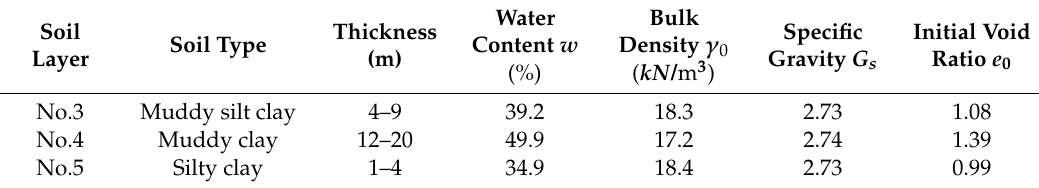
Table 2. Physical properties of the model soils.